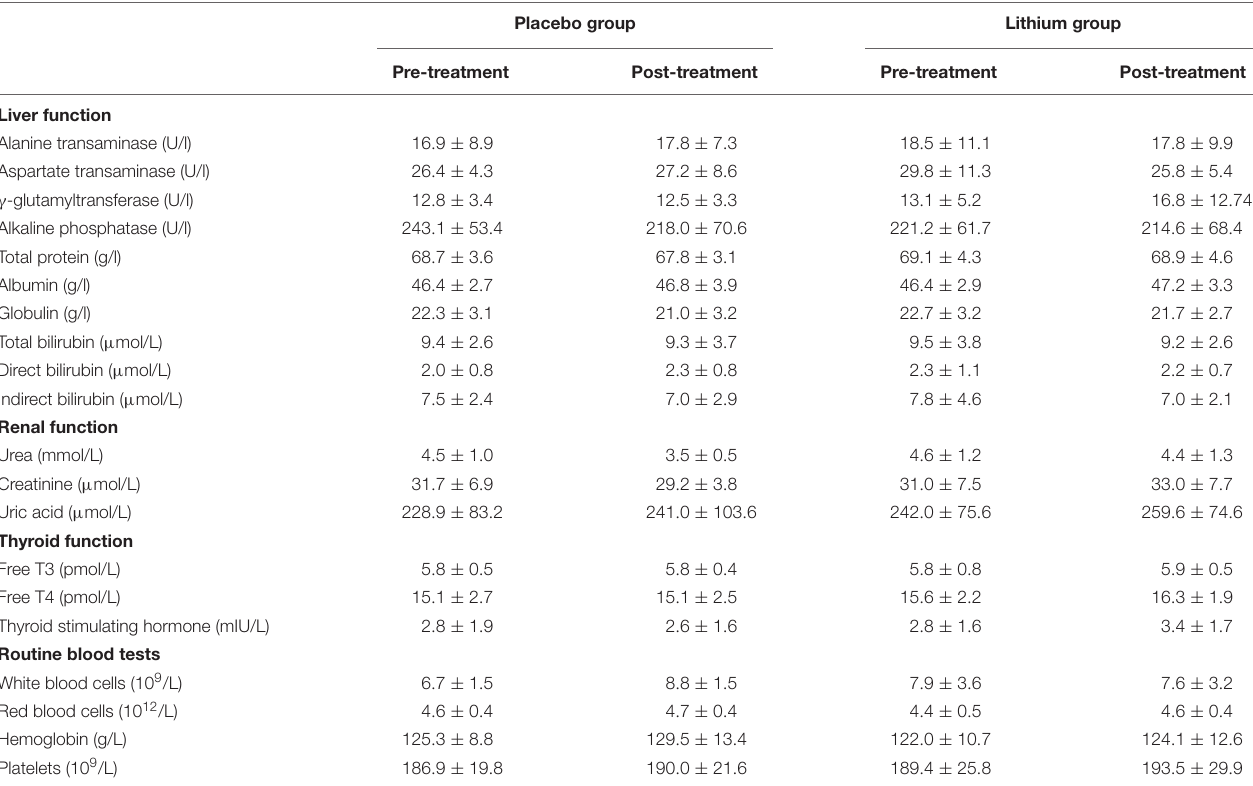
TABLE 3 | Laboratory examinations during the treatment period (means ± SD).